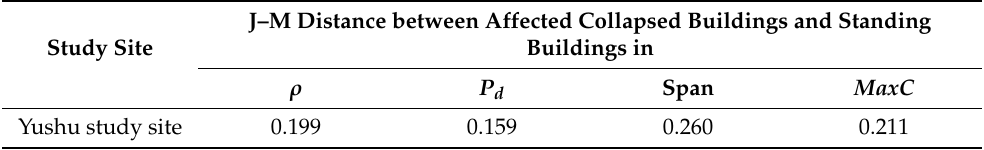
Table 2. J–M distance between affected collapsed buildings and standing buildings in different polarization